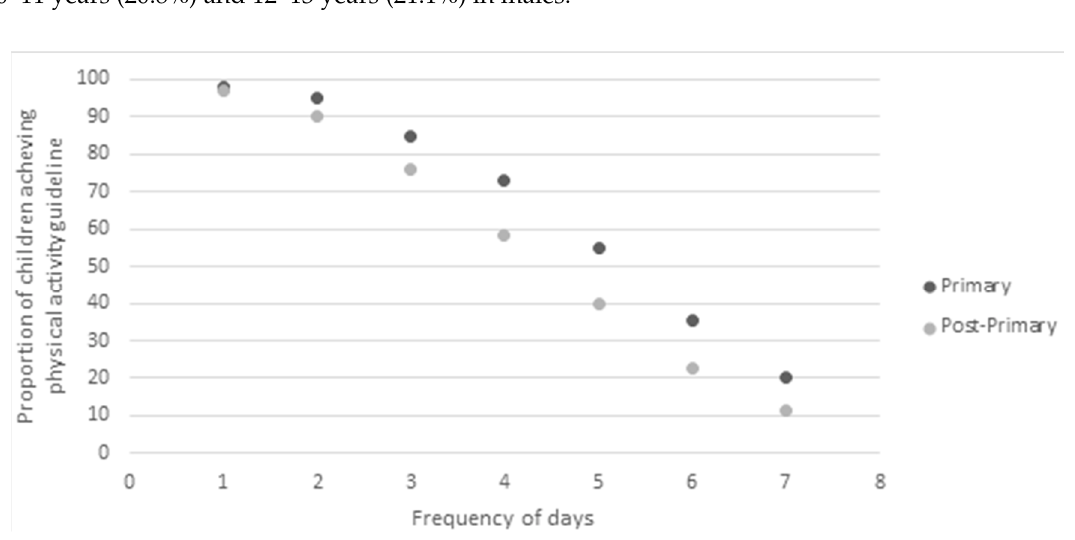
Table 3. Enjoyment and social support for physical activity.